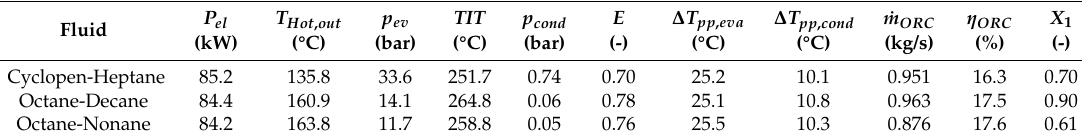
Table 5. Most promising mixtures using ICE nameplate data.